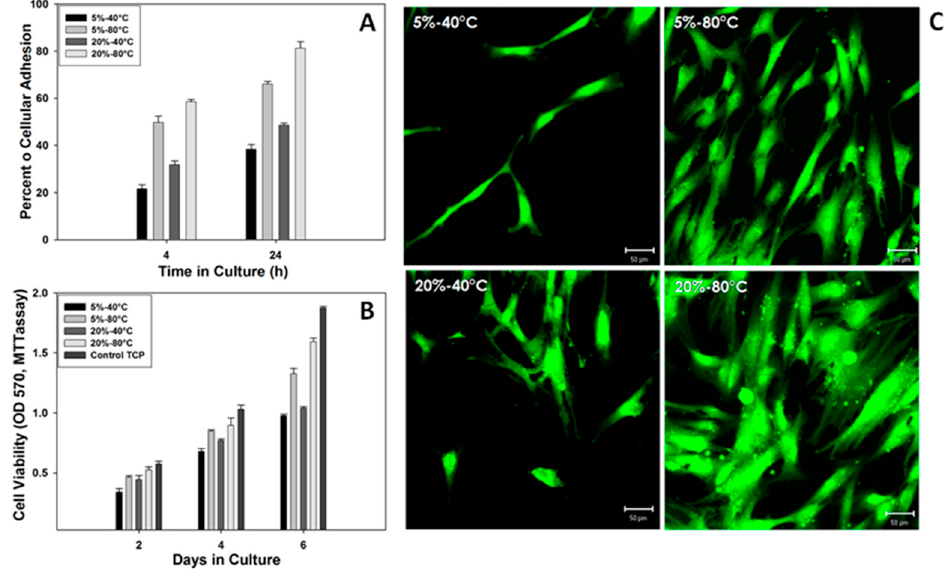
Figure 6. hMSC in vitro culture: ( A ) adhesion, ( B ) viability tests and ( C ) morphology of cell bodies Figure 6 . hMSC in vitro culture: ( A ) adhesion, ( B ) viability tests and C) morphology of cell bodies via confocal via confocal microscopy.